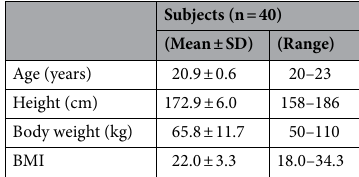
Table 1. Participant profiles in Experiment 1.